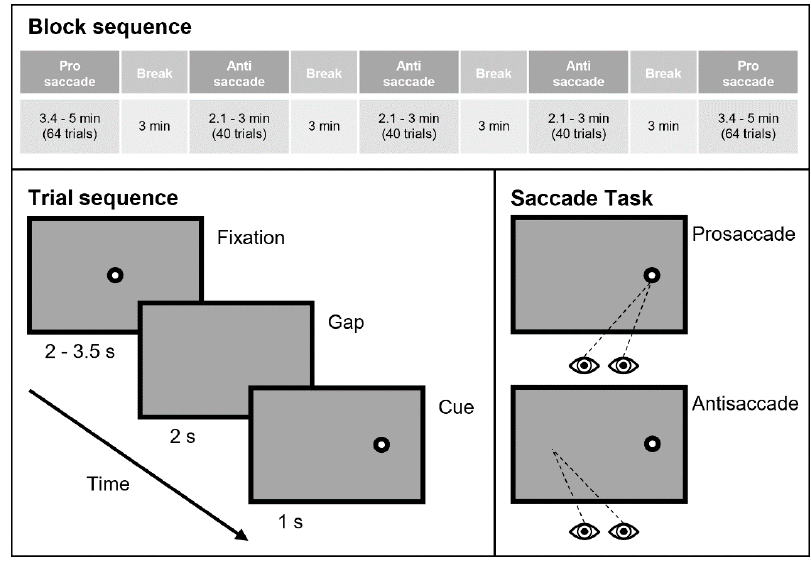
Figure 1. Saccade task protocol. The experiment consisted of five blocks of trials, in the order of pro, anti, anti, anti, pro. In each trial, the target appeared for 2 to 3.5 s in the center of the screen for fixation, then disappeared for 0.2 s (gap period). Then the circle randomly appeared again on the left or right side of the screen, and after 1 s, went back to the center and repeated the entire sequence. A detailed description of the Saccade task’s judgment and measurement is given in the next subsection.